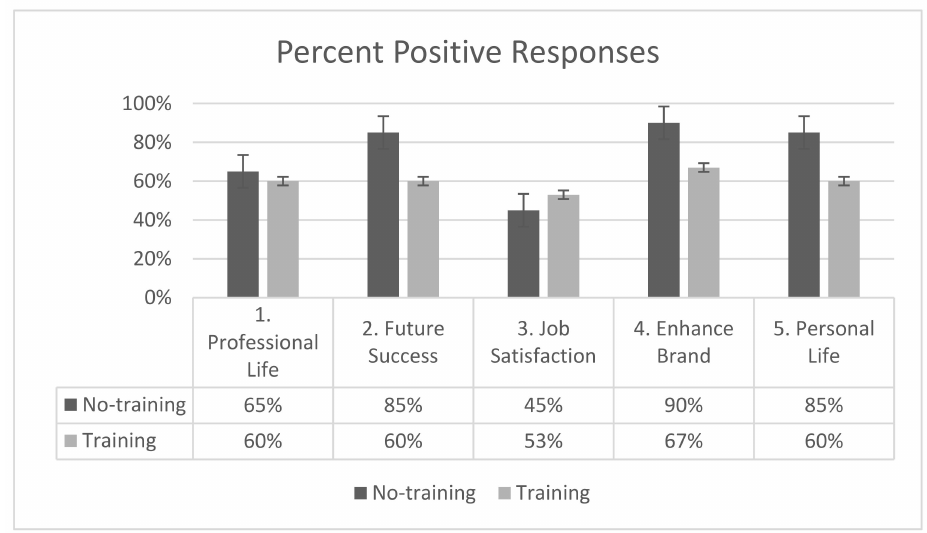
Figure 6. Sustainability engagement index percent positive scores at the pre-intervention stage.